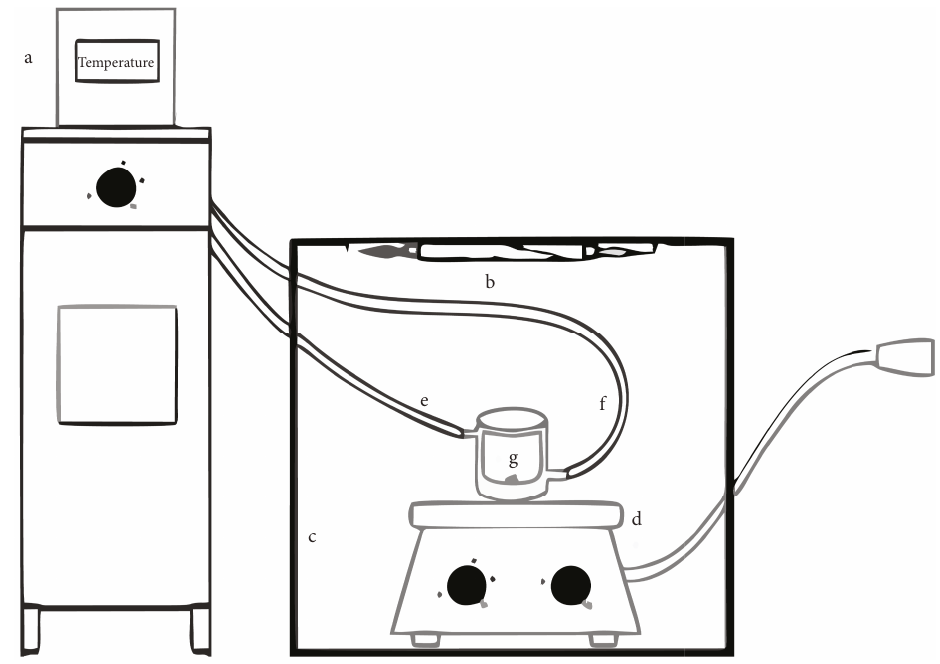
Figure 2: Photolytic degradation: (a) water, (b) radiation source, (c) container, (d) agitation plate, (e) and (f) in and o ff recirculation water, and (g) reaction